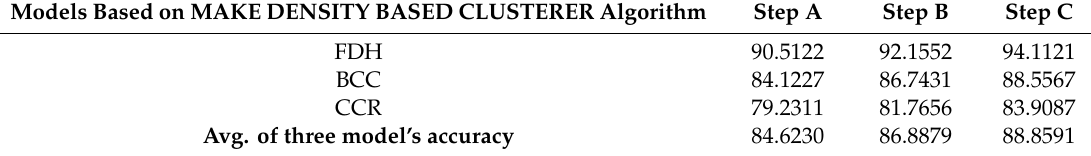
Table 16. Accuracy comparison contained by MAKE DENSITY BASED CLUSTERER algorithms (All Numbers Are in